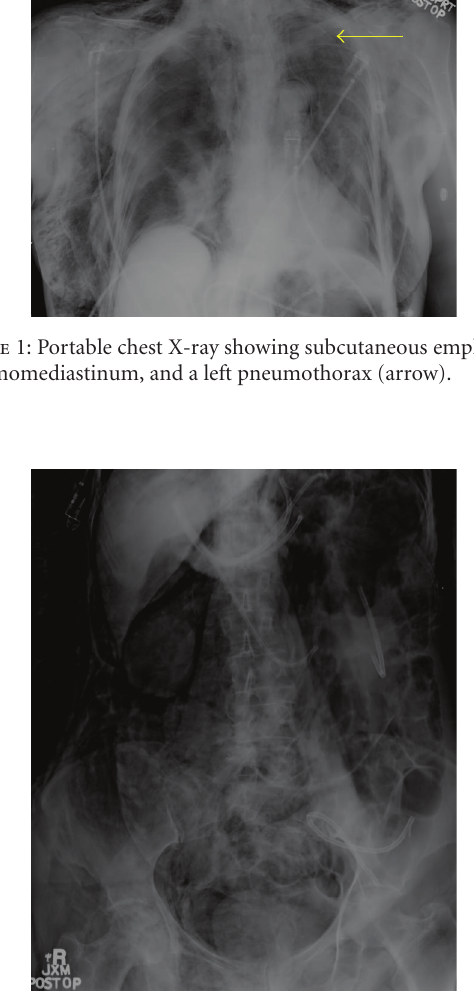
Figure 2: Portable abdominal X-ray showing retroperitoneal and intraperitoneal-free air.